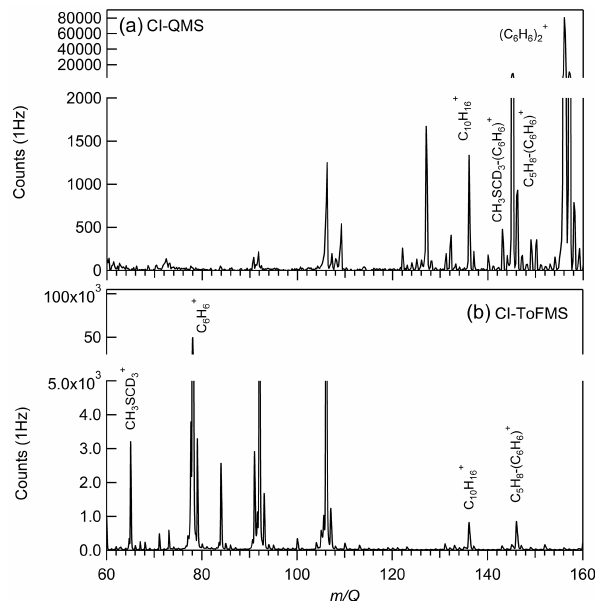
Figure 1. CI-QMS (a) and CI-ToFMS (b) mass spectra utiliz- ing benzene reagent-ion chemistry while sampling a mixture of dimethyl-1,1,1-d 3 sulfide, isoprene, and α -pinene standards at 40% relative humidity and room temperature. The weaker field strength ) of the CI-QMS transmits clustered forms of benzene ((C 6 H 6 ) + 2 ) . Both are de- and dimethyl-1,1,1-d 3 sulfide (CH 3 SCD 3 -C 6 H + 6 tected at nominal mass by the CI-ToFMS. Isoprene is detected as ) and α -pinene (C 10 H + ) appears at a benzene cluster (C 5 H 8 -C 6 H + 6 16 nominal mass on both instruments.